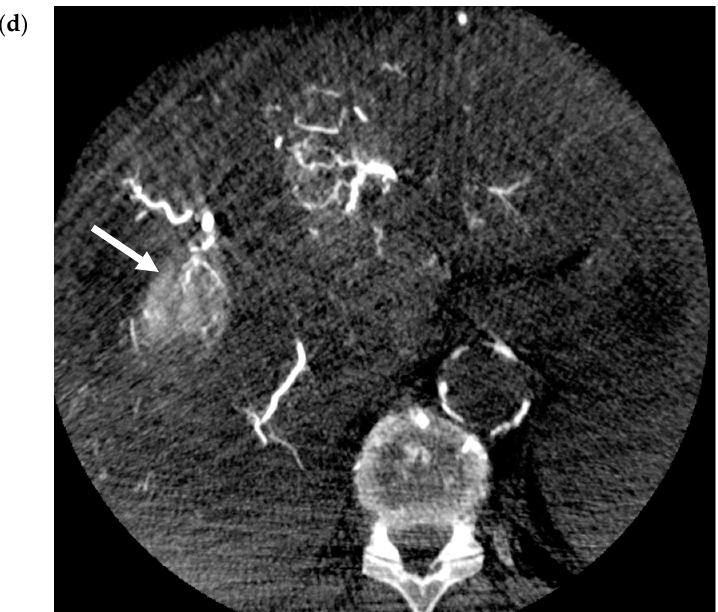
Figure 2. Transarterial Embolization (TAE) of HCC. ( a ) Pre-procedure triphasic contrast-enhanced CT in the arterial phase. Mass with arterial hyperenhancement in segment 8 of the right lobe of liver (white arrow), consistent with hepatocellular carcinoma (HCC). ( b ) Digital subtraction angiogram of the right hepatic artery pre-bland embolization. Mass (white arrow) is supplied by the segment 8 branch of the right hepatic artery (black arrow). ( c ) Digital subtraction angiogram of the right hepatic artery post-bland embolization of the segment 8 branch of the right hepatic artery. A combination of 40-120-µm microspheres and 100-µm polyvinyl alcohol (PVA) particles were used. Angiogram demonstrates the stasis of iodinated contrast in the segment 8 arterial branch with pruning of the distal branches and no opacification of the mass. ( d ) Intra-procedural cone-beam CT immediately post-bland embolization. Retention of iodinated contrast and particles in the treated tumor (white arrow) identical to pre-procedure post-contrast images indicative of complete tumor coverage.